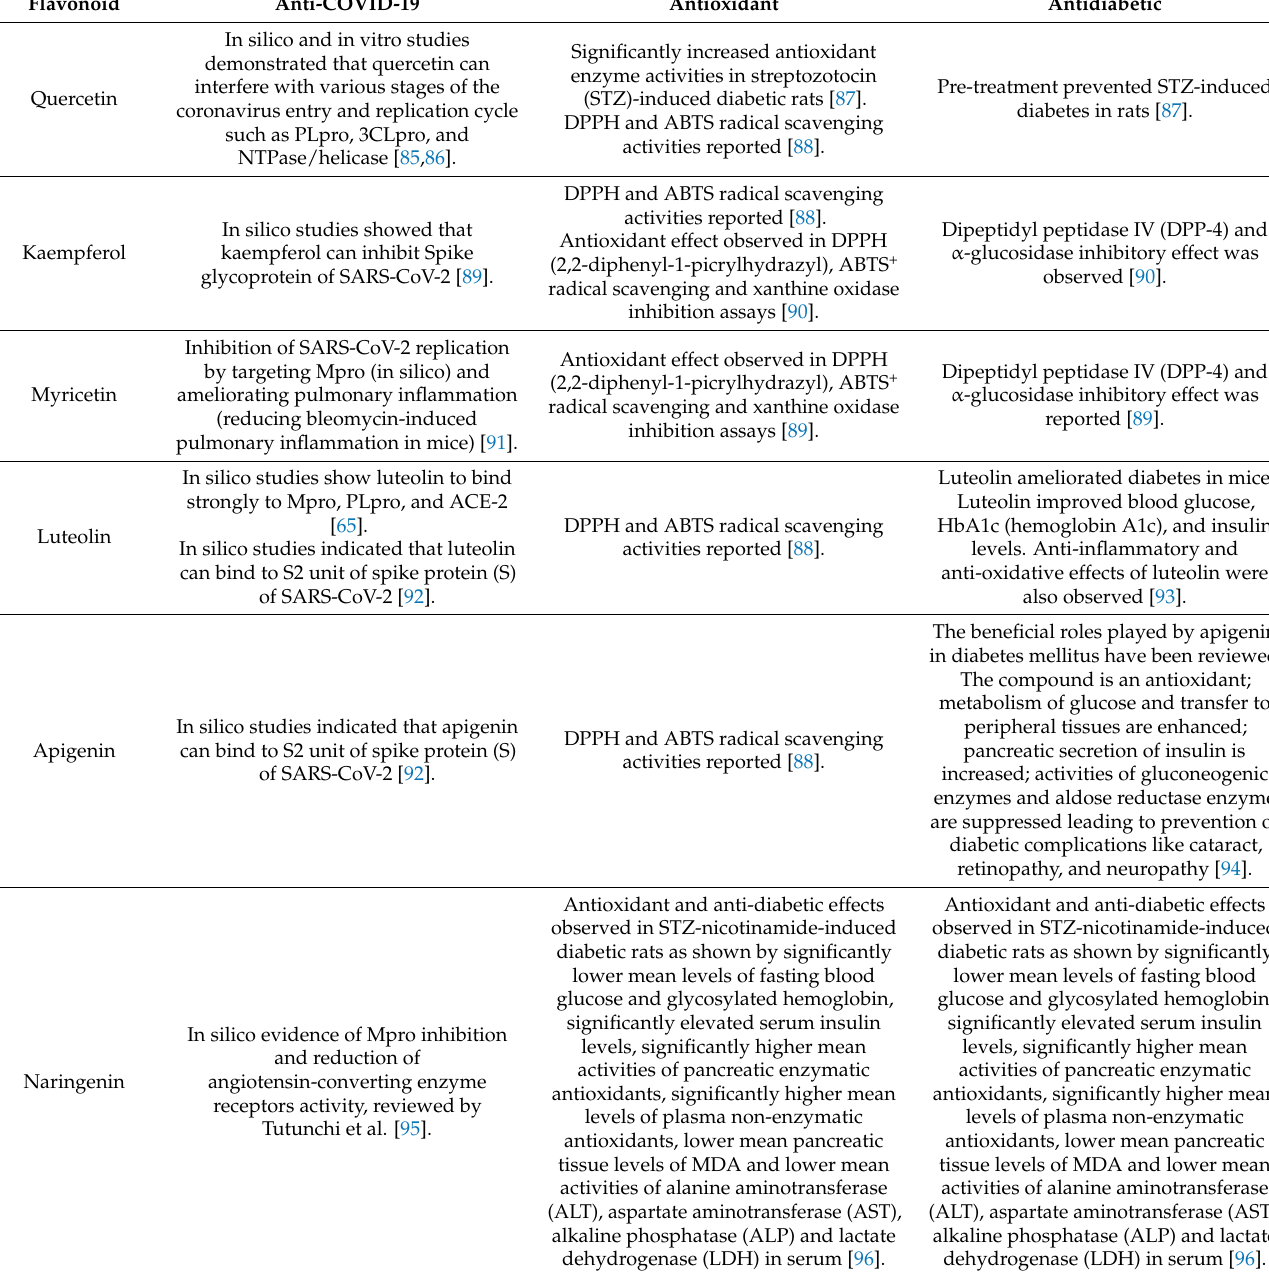
Table 1. Several dietary flavonoids with anti-COVID-19, antioxidant and antidiabetic